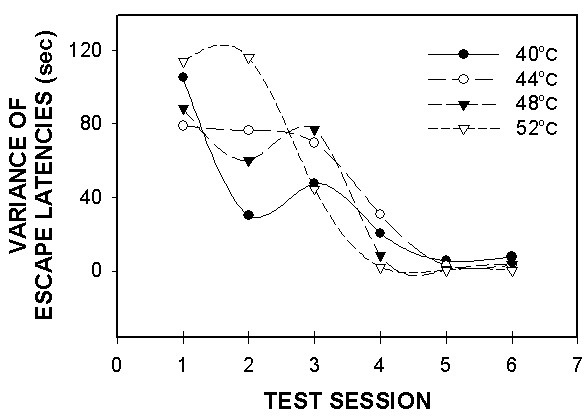
AlgoTrack escape latency variance in sham rats (n = 8) for 4 temperatures (40, 44, 48 and 52°C) as a function of test session. Variances for all temperatures tested decreased by the fourth testing session, and were maintained through further testing.